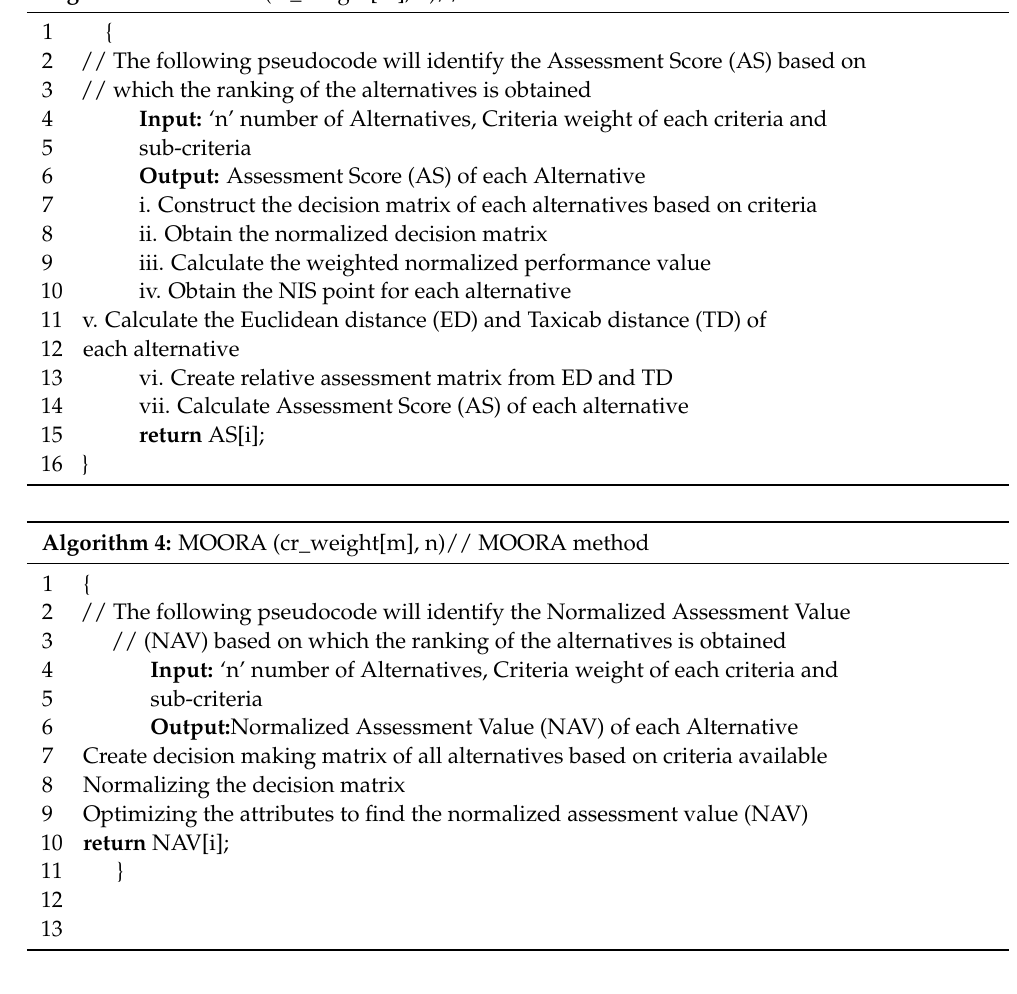
Algorithm 3: CODAS (cr_weight[m], n)// CODAS method